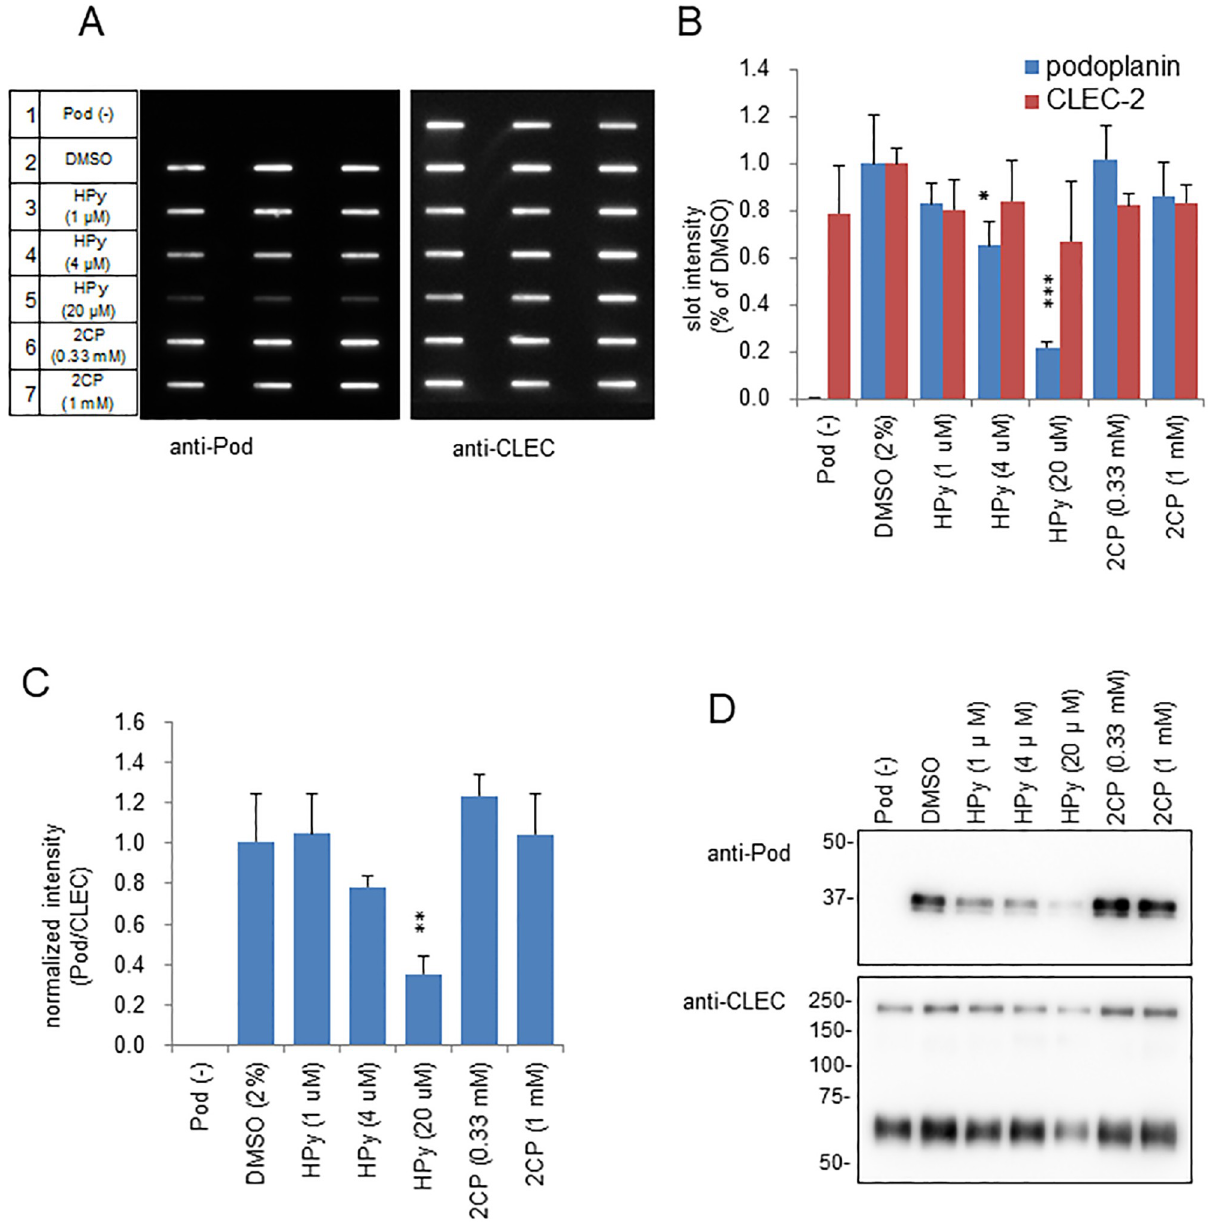
Fig 5. Slot blot analysis of the effects of hematoporphyrin and 2CP on the binding of Fc-CLEC-2 to podoplanin. (A) Slot blot analysis of the levels of podoplanin and CLEC-2 in the elution fraction from complexes formed in the presence or absence of the indicated concentrations of hematoporphyrin (HPy) or 2CP. Complexes were formed with 25 μ g/mL Fc-CLEC-2 and 1.5 mg/mL pod-HeLa lysates (standard combination). HPy or 2CP was pre-incubated with Fc-CLEC-2 for 30 min before mixing with pod-HeLa lysates, and the subsequent procedures were conducted under dark. Ten μ L of acid-elution fraction were analyzed by slot blotting. The set of blots shown are one representative result performed in triplicate. (B) Relative slot intensities of podoplanin and CLEC-2 in (A). Slot intensities were normalized to those of the DMSO control (2%) and expressed as mean ± SD of triplicate assays. A slight decrease in the recovery of Fc-CLEC in Pod (-) samples was due to its absorption into the plastic ware, which was otherwise prevented by a large amount of cell lysate proteins. (C) The ratio of podoplanin to CLEC-2. Podoplanin slot intensities were normalized to the respective CLEC-2 intensity values in (B). (D) Western blot analysis of acid-eluted fractions. Equal proportion of three replicates of acid-eluted fractions in (A) were pooled, and 10 μ L was analyzed by the respective antibody. Data shown are a representative result from at least two independent experiments with similar results. Statistical significance is as follows: � , P < 0.05 and �� , P < 0.01, ��� , P < 0.001.